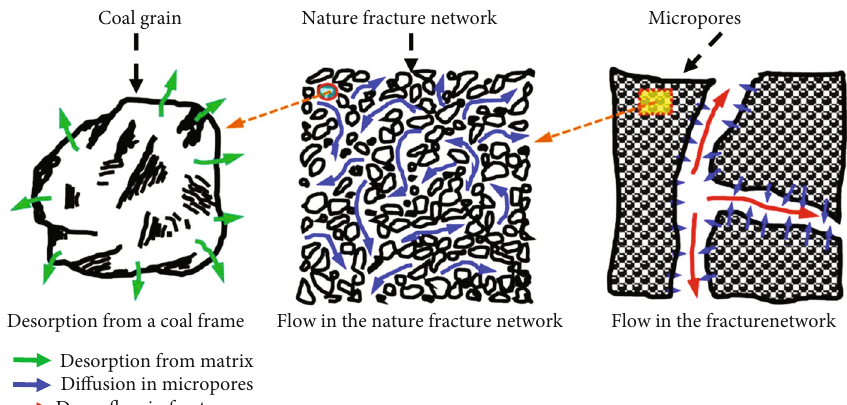
Figure 1: Desorption and di ff usion in the matrix and Darcy fl ow in the fracture.